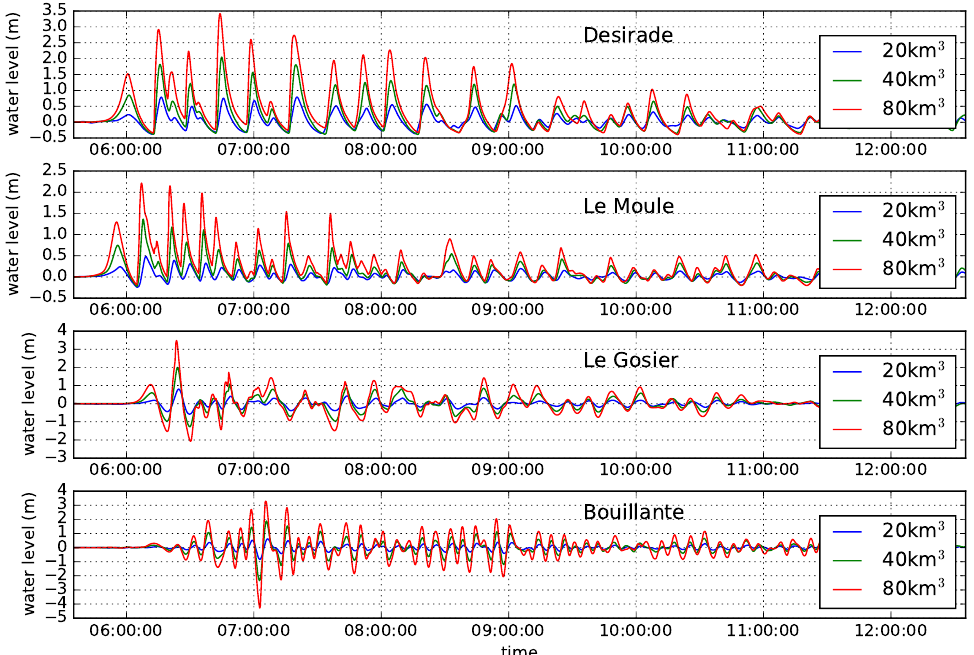
Figure 4. Arrival time after the collapse (including the 20 min initial simulation) at the stations located on Figure 1 and water elevation for the 3 cases 20, 40 and 80 km 3